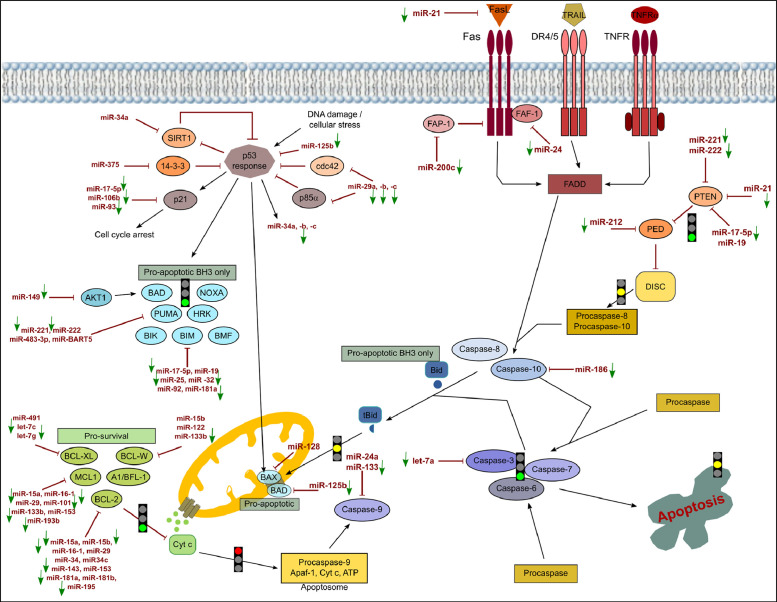
The core apoptotic pathway and its regulation by miRNAs in THP-1 cells exposed to the highest dose of CdS QDs. The figure depicts events in the intrinsic and extrinsic apoptotic pathways. In the whole pathway, point and block arrows indicate activation or inhibition, respectively. In the experimental conditions, the arrows next to the miRNAs indicate an increase or decrease of the miRNA. A green arrow indicates a decrease with lack of repression of its specific target. As a result, the specific step is unlocked (green light) or locked (red light) or could be unlocked (yellow light).Note: DIANA-Tarbase database and DIANA-mirPath were used to obtain the data to create this chart.